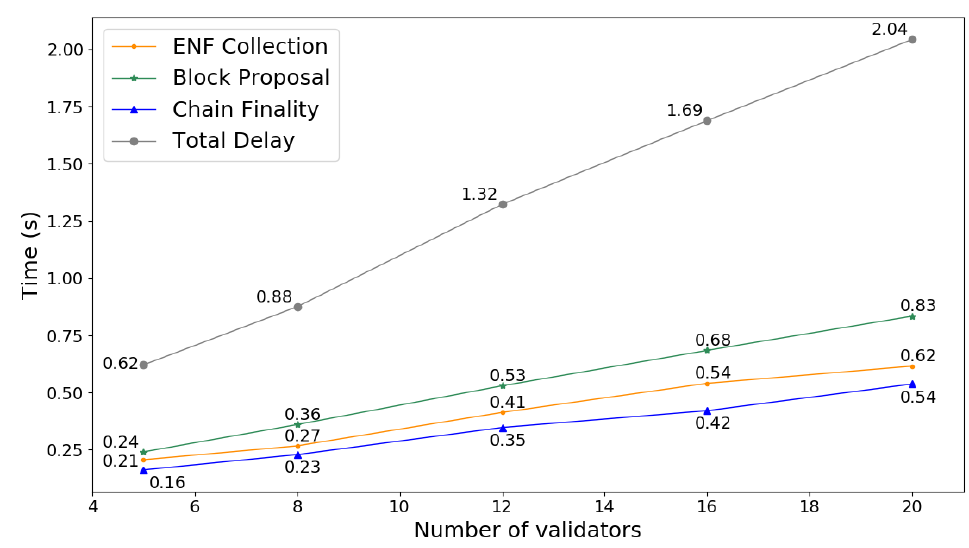
Figure 4. Latency for an epoch cycle of PoENF consensus with different committee size.